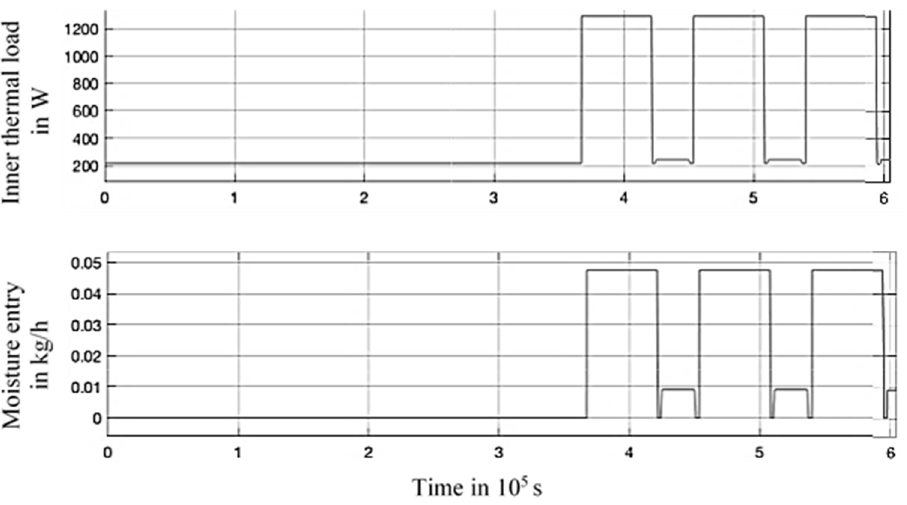
Figure 3. Scaled internal loads of the production hall over seven days.